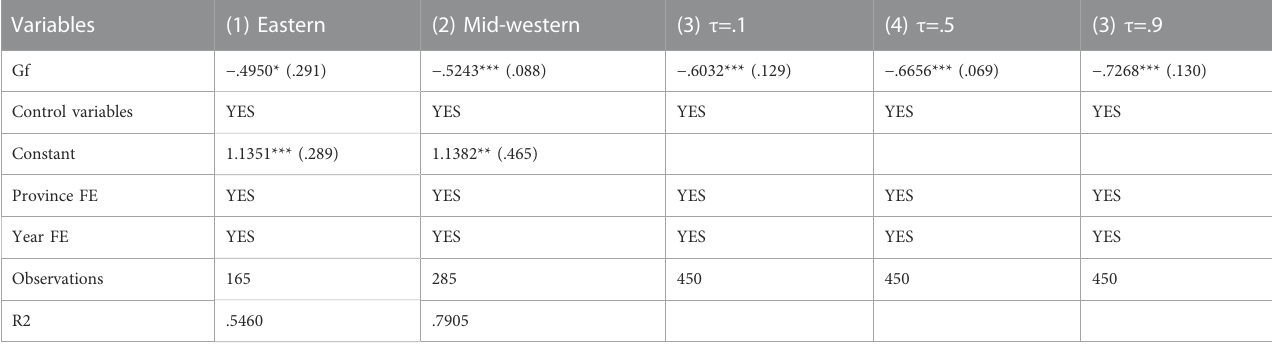
TABLE 7 The results of geographical heterogeneity and quantile regression results.